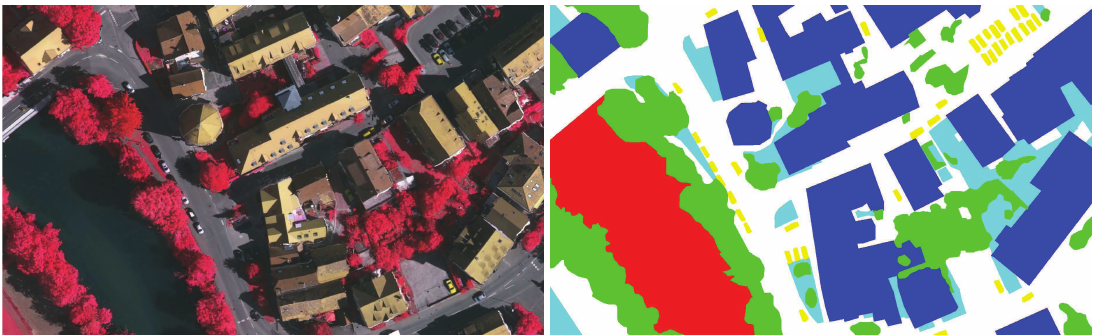
Figure 3. A demonstration of the training sample: ( left ) the original image; ( right ) the manually labeled ground truth map in which different object classes are marked with different colors, e.g., buildings with blue, cars with yellow, trees with green, low vegetation with cyan, water with red and impervious surface with white.